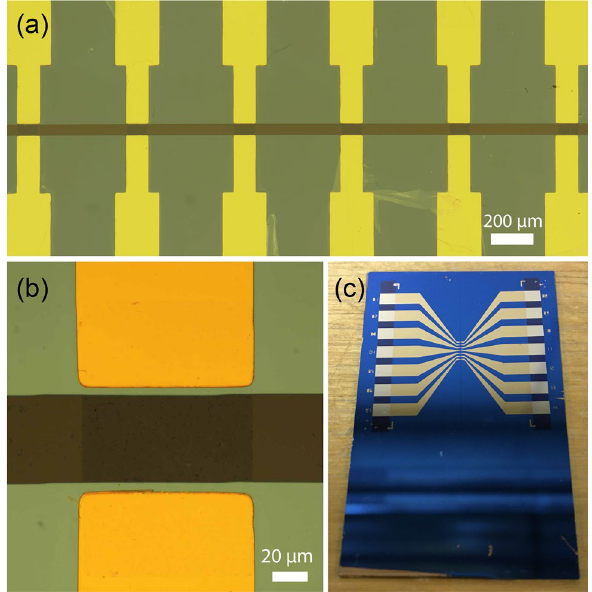
Figure 4. ( a ) Optical micrograph of the fabricated GFET channels after Al 2 O 3 etching process (only six of the seven channels are visible). ( b ) A closer look into one of the GFET channels. ( c ) Overall view of the fabricated 7-channel GFET before the bonding of microfluidic PDMS layer.